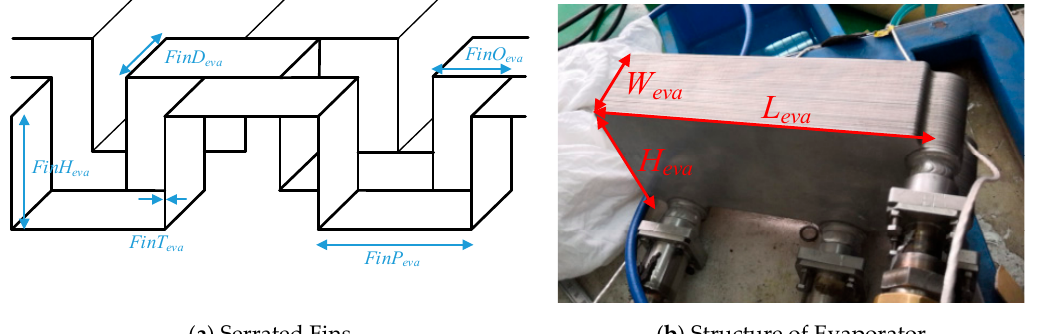
Figure 8. Schematic diagram of evaporator.